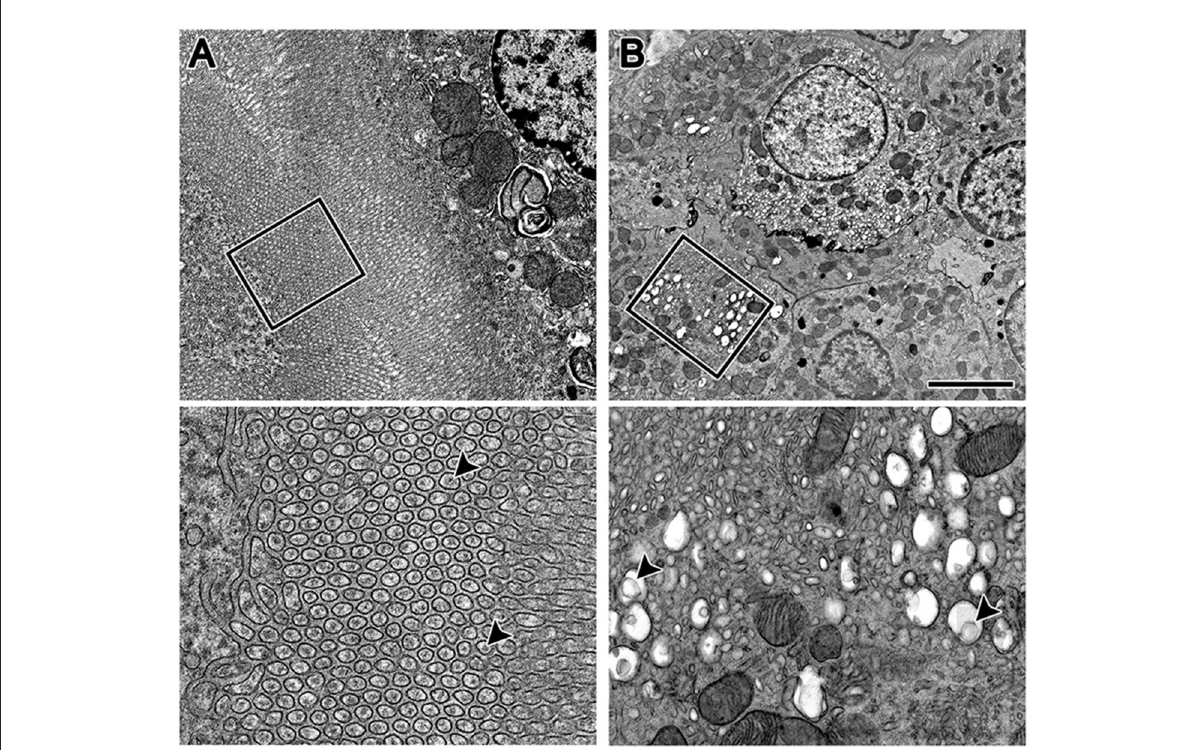
FIGURE3 Mouse hepatocytes after ingestion of 20 and 200nm PSNS, fixed and stained by the conventional method, and imaged by transmission electron microscopy. (A) Top panel: Lawns of tubule-like structures in hepatocytes were apparent in livers after ingesting 20nm PSNS, as well as after ingesting control vehicle and 200nm PSNS. However, after ingesting 20nm PSNS only, increased magnification by 4X (boxed region; bottom panel) revealed that each tubule contained round particles (arrowheads) that were similar in diameter to the 20 PSNS that were ingested. (B) Top panel: After ingesting 200nm PSNS, there were large vacuoles present in many of the hepatocytes. Increased magnification by 4X (boxed region; bottom panel) revealed that several of the vacuoles contained large circular structures that were similar in diameter to the 200nm PSNS that were ingested. For example, the circular structure indicated by the arrowhead on the left side of the panel is 226nm in diameter, and on the right side of the panel is 213nm in diameter. Scale: (A) top = 2 µ m, bottom = 500nm; (B) top = 4 µ m, bottom = 1 µ